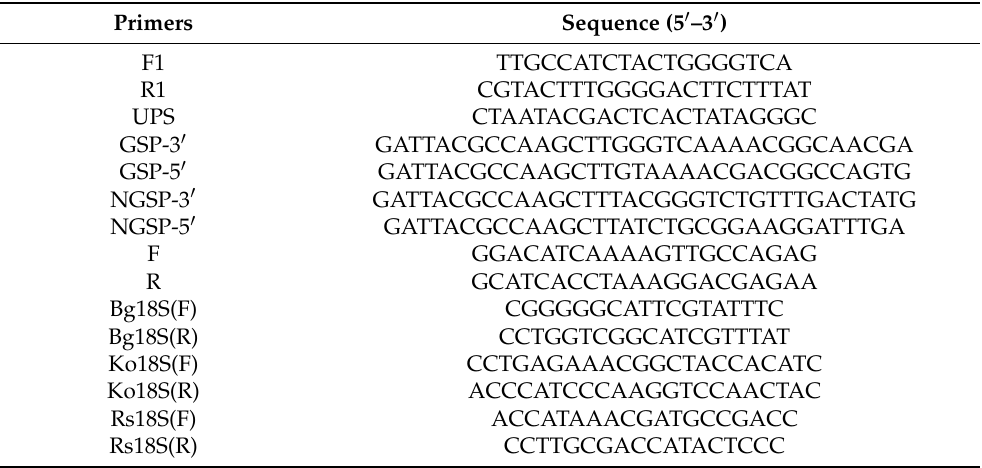
Table 2. List of primers for PCR, RACE, and real-time PCR experiments. Primers Sequence (5 (cid:48) –3 (cid:48) )